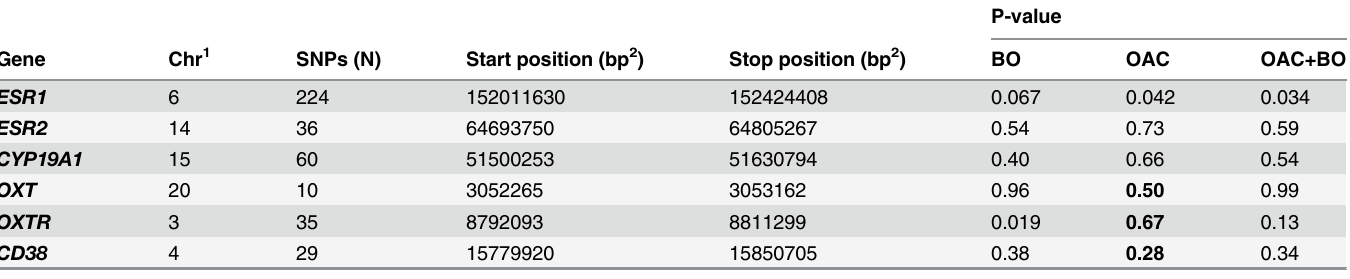
Table 2. Gene-based analysis of genes known to regulate oestrogen levels and oxytocin levels and risk of Barrett ’ s oesophagus (BO), oesopha- geal adenocarcinoma (OAC), and these conditions combined (OAC+BO). P-values in bold are statistically significant after correction for multiple testing.